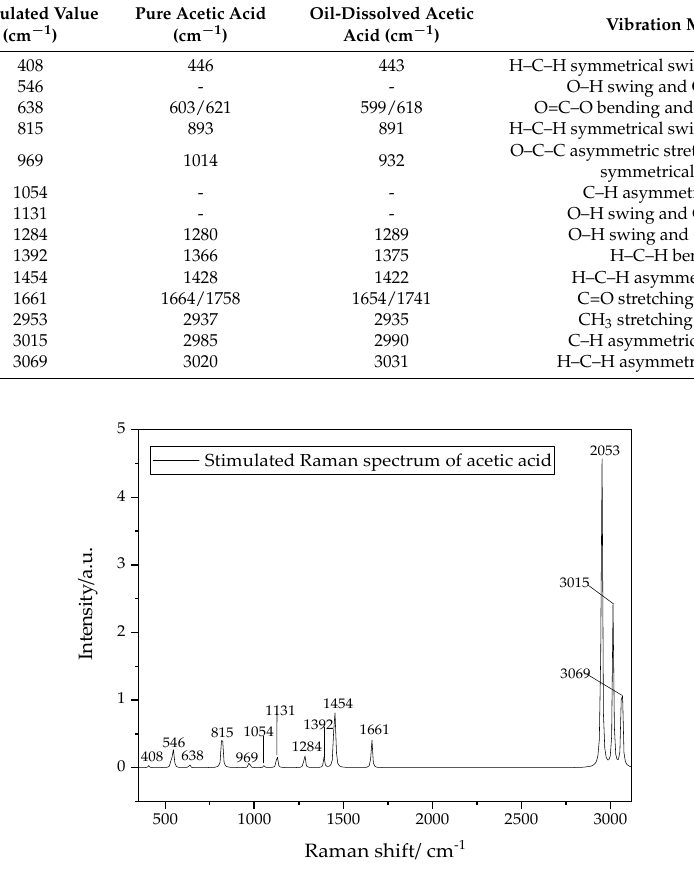
Figure 3. Stimulated Raman spectrum of acetic acid.